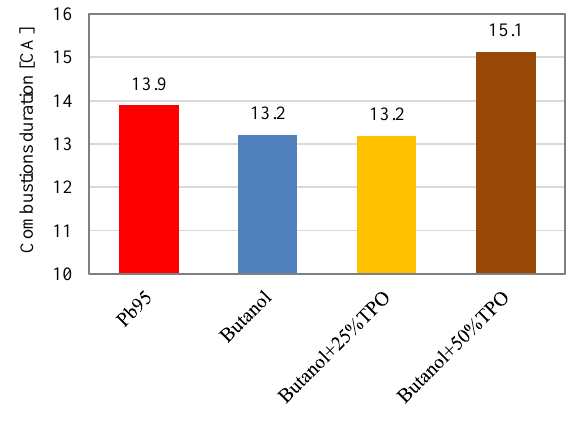
Fig. 10. Combustions duration for various fuels in